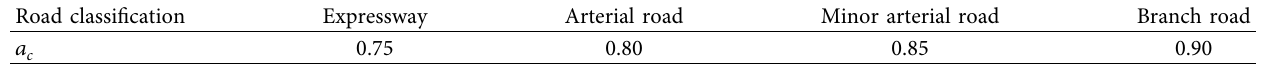
Table 7: Coefficient of the road classification [24].